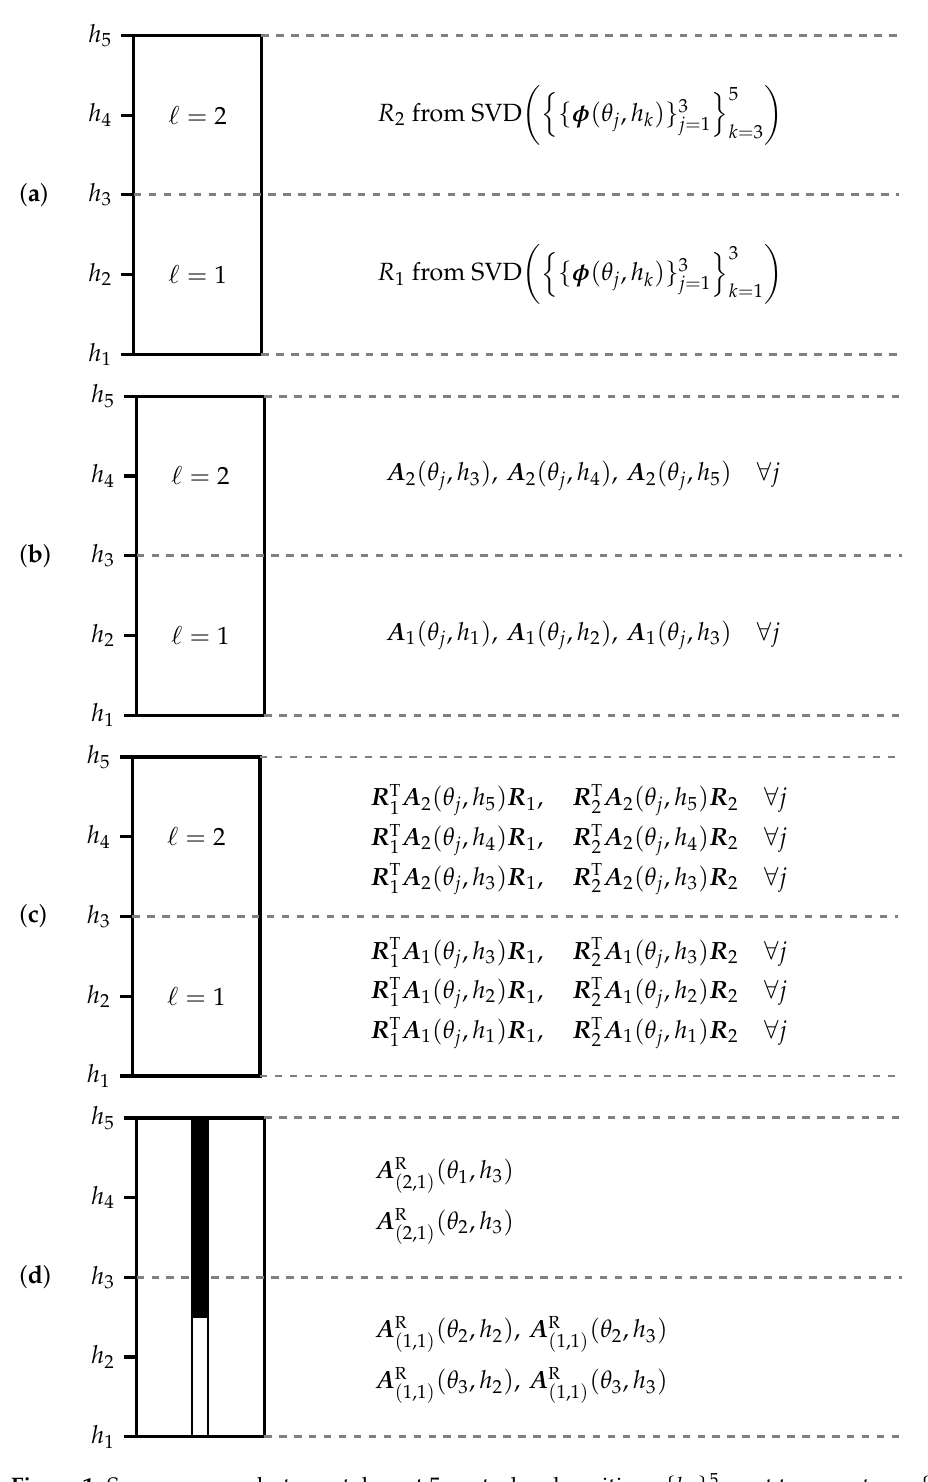
, at temperatures { θ j } 3 j = 1 k = 1